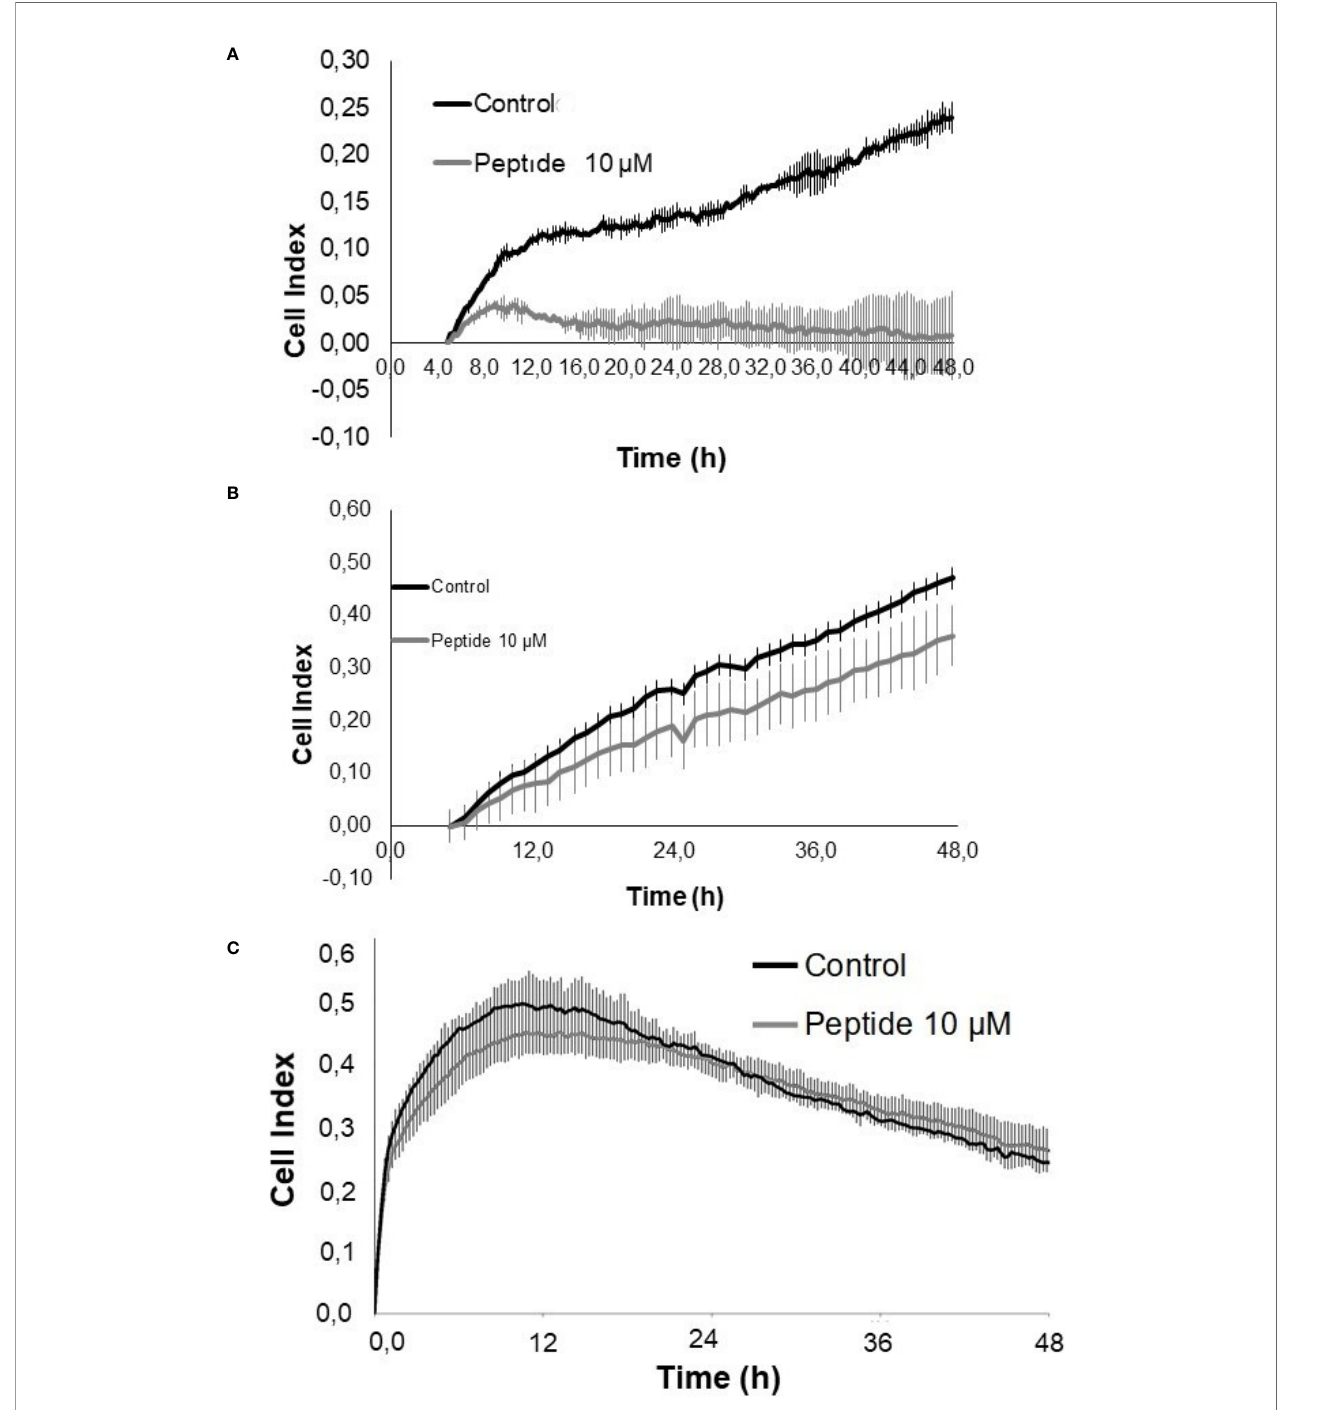
FIGURE 6 | Cell proliferation/viability assay in the presence of growth factors. HUVEC cells were cultured for 50 hours on collagen type 1 in medium containing 2% fetal bovine serum (FBS) and 20 ng/mL FGF-2 or 50 ng/mL VEGF-A, in the presence or absence of the HS-binding peptide. (A) VEGF-A + 2% SFB. (B) FGF-2 + 2% SFB. (C) 2% SFB. Control, HUVEC cells in the absence of treatment. Peptide, HUVEC cells with HS-binding peptide treatment (10 µM). Assay performed in triplicate. The values indicate the mean and standard deviation of the cell index (index proportional to the number of cells adhered to the plate). Peptide inhibited FGF-2 proliferation. Each point of FGF-2 assay was statically signi fi cant p<0.05 (Kruskall-Wallis) while the decrease of proliferation/viability with VEGF-A was not signi fi